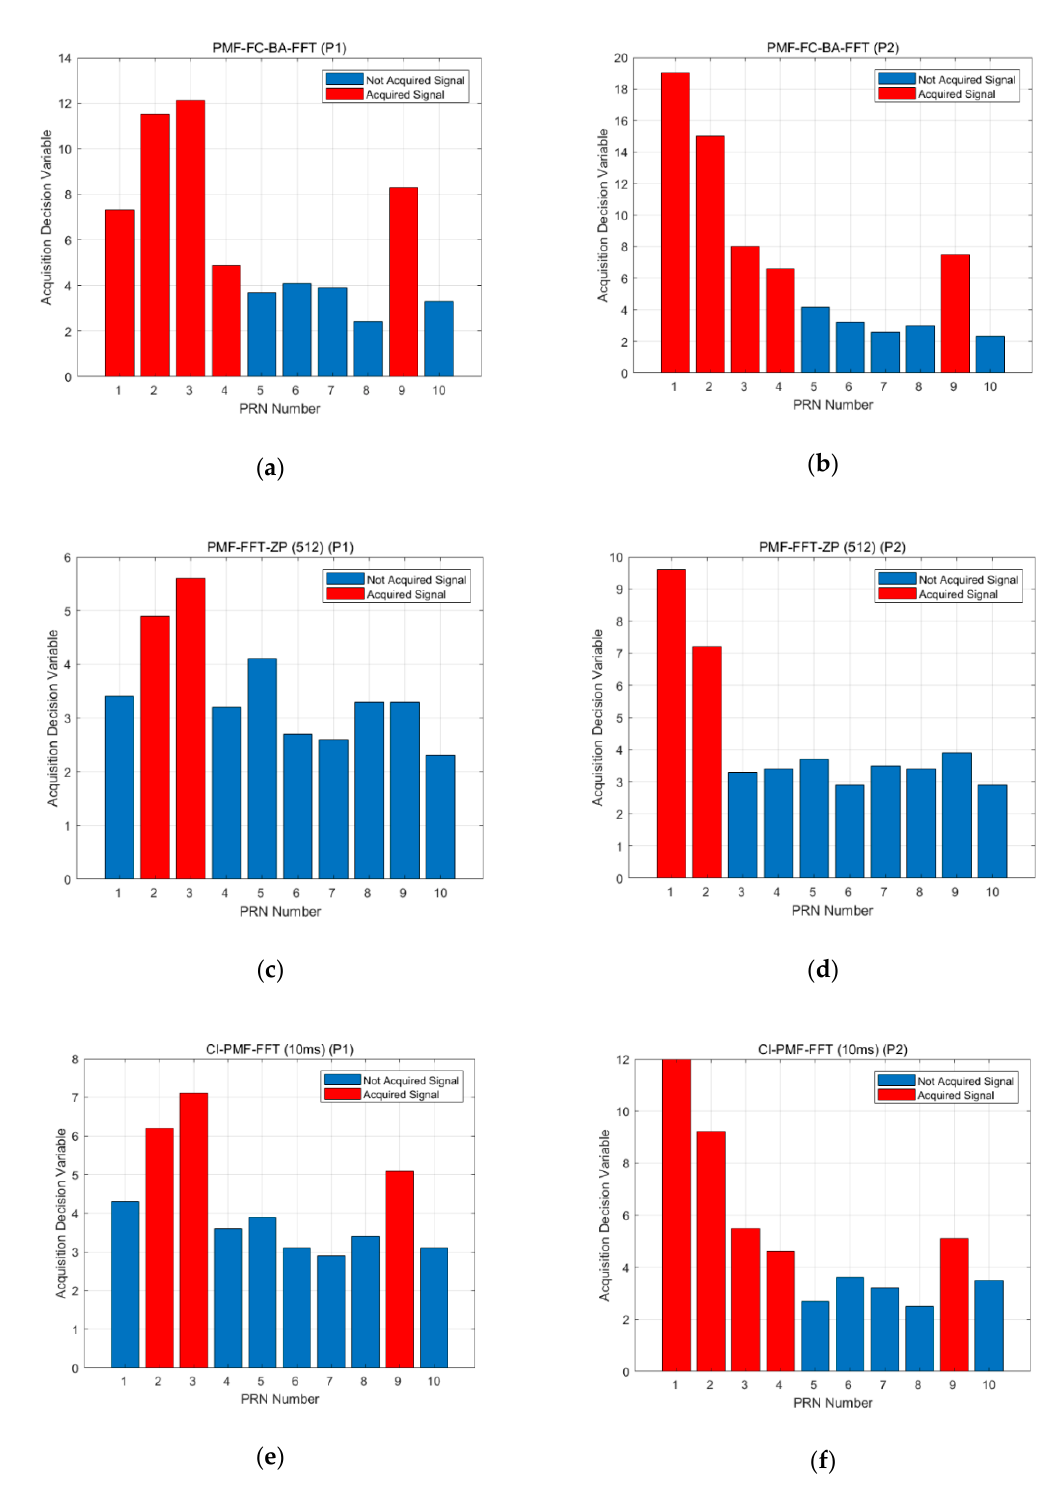
Figure 19. Acquisition result of experimental tests using different acquisition method at test point P1 and P2. ( a ) PMF-FC-BA-FFT (P1); ( b ) PMF-FC-BA-FFT (P2); ( c ) PMF-FFT-ZP (512) (P1); ( d ) PMF-FFT-ZP (512) (P2); ( e ) CI-PMF-FFT (10 ms) (P1); ( e ) CI-PMF-FFT (10 ms) (P2).